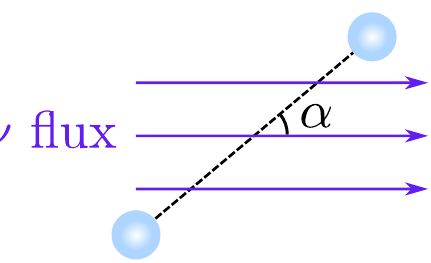
Figure 2 . An illustration of neutrino forces between two objects in a directional neutrino flux